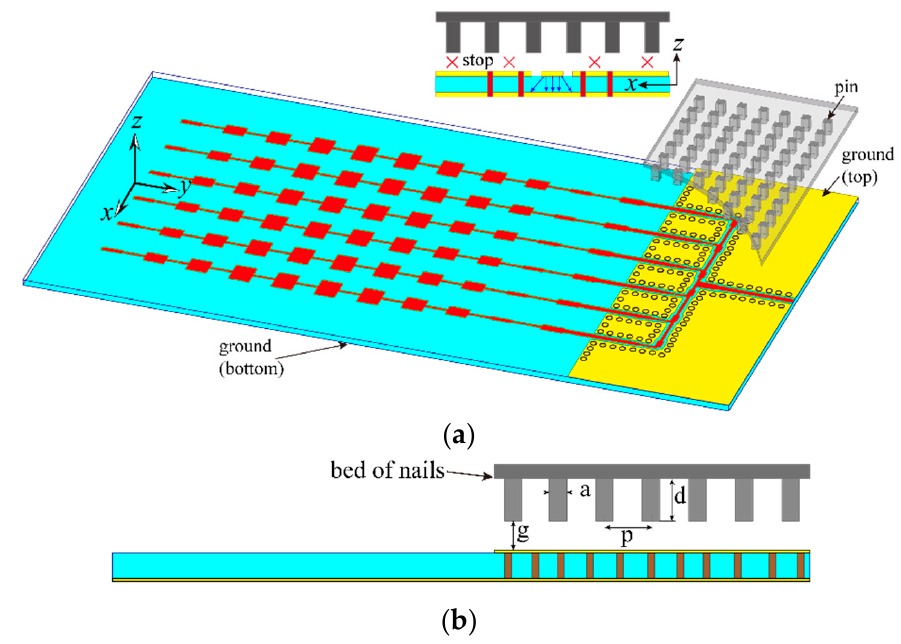
Figure 11. The configuration of the proposed low-SLL planar array. ( a ) 3-D view. ( b ) Side